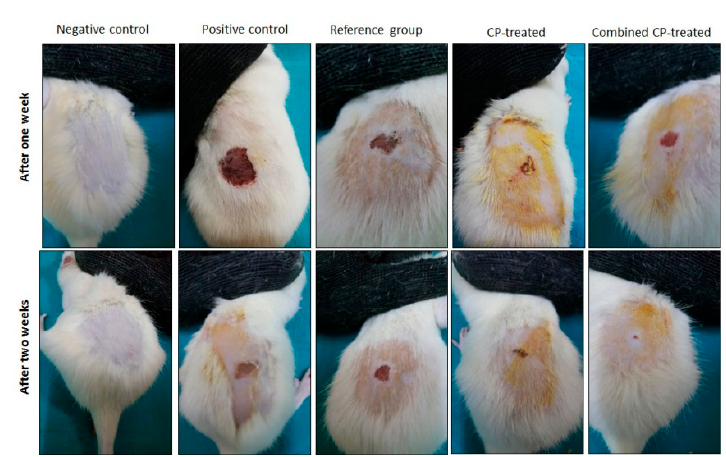
Figure 2. Macroscopic progress of wound healing process in the study groups. CP: Cucurbita pepo L.